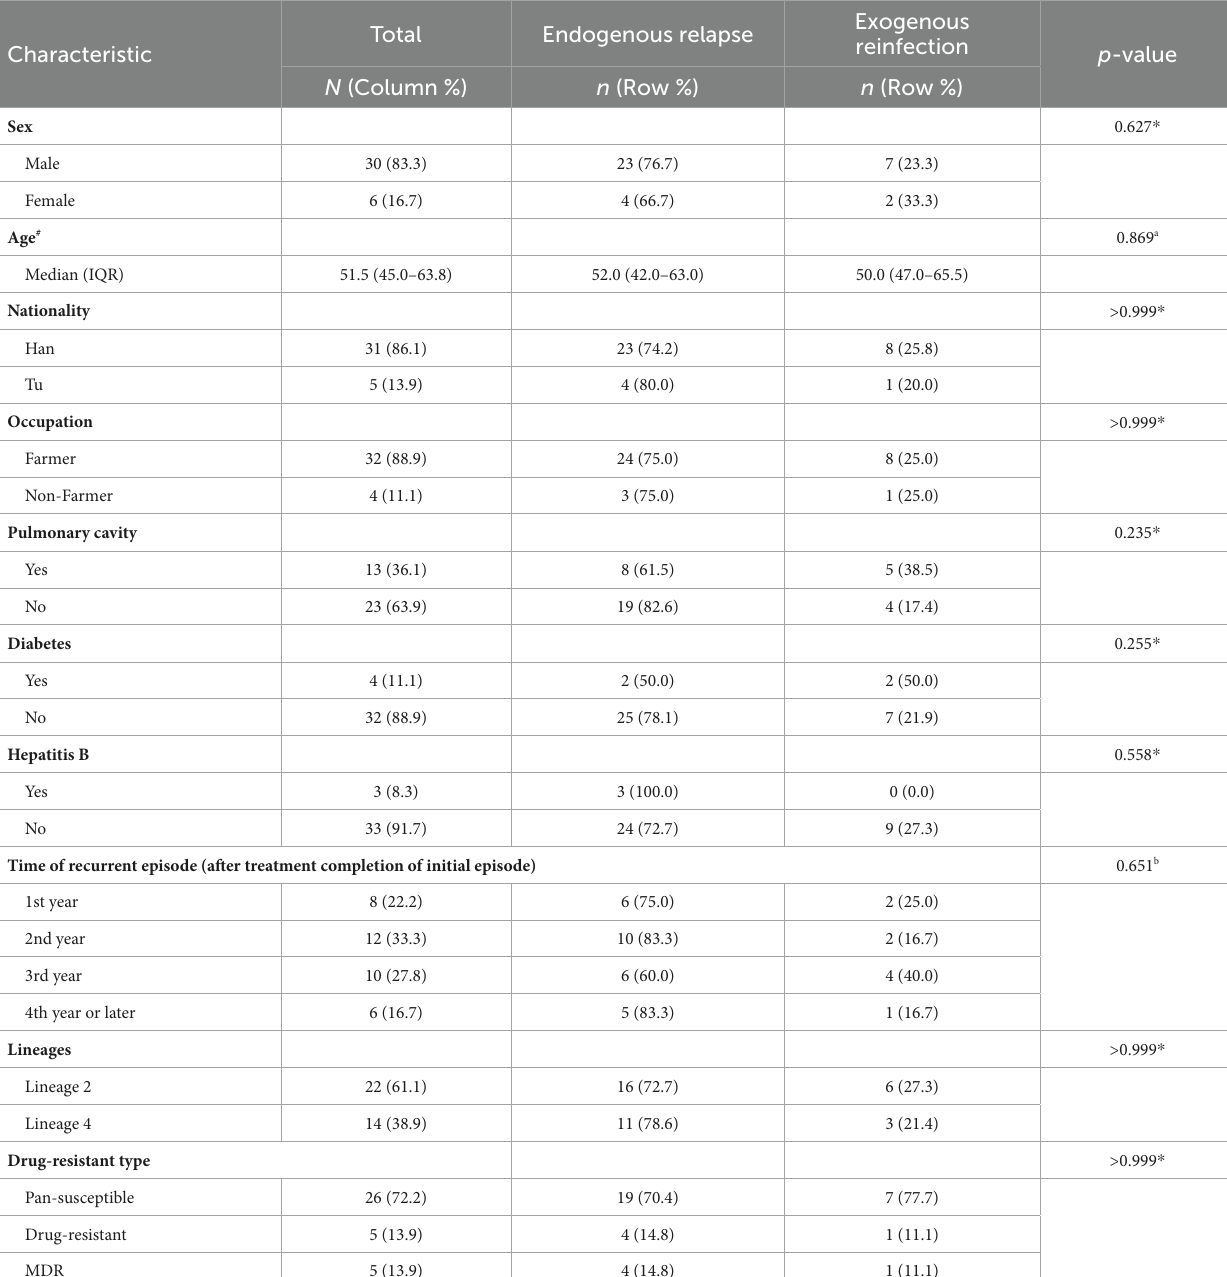
TABLE 2 Initial episode characteristics in cases with TB relapse and reinfection.